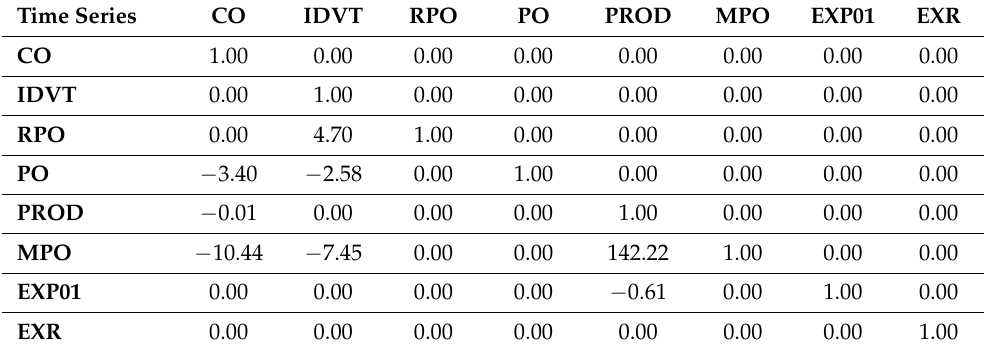
Table 11. Structural matrix A after replacing SBO with RPO.